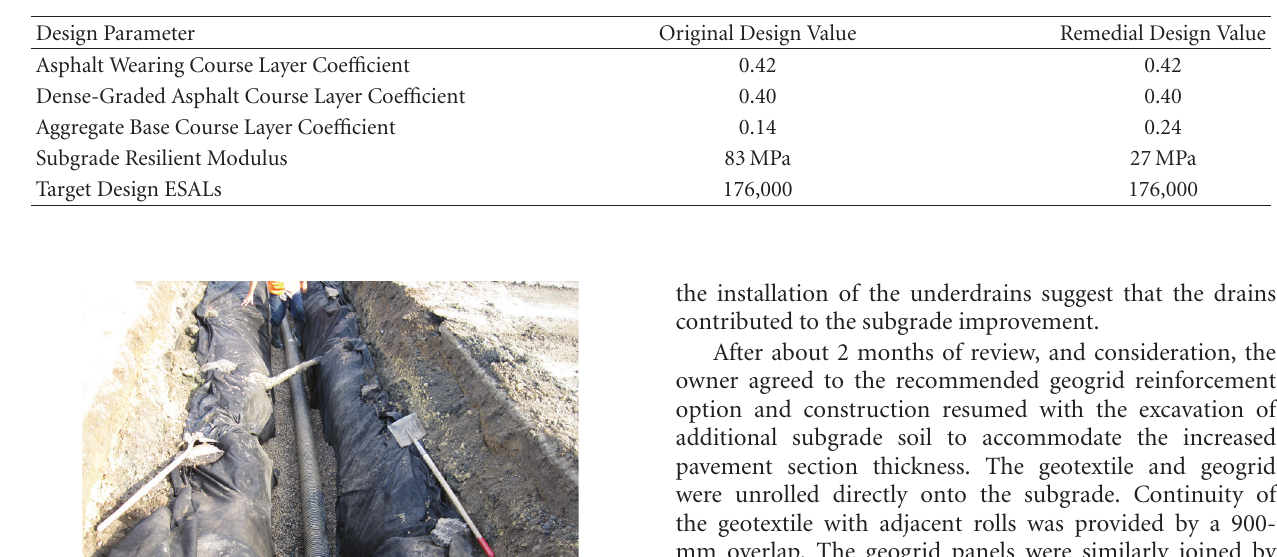
Table 2: Summary of AASHTO [3] Design Inputs Used to Analyze Pavement Sections. Original design value for resilient modulus was inferred from project specifications. Design ESALs were back calculated from original design pavement section.